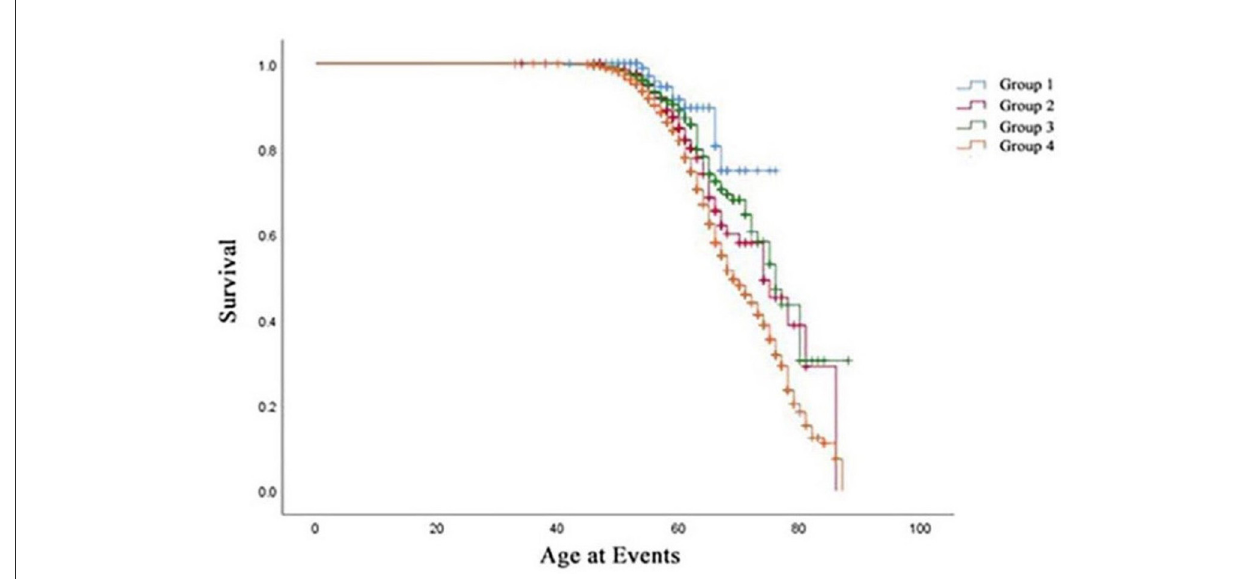
FIGURE5 Kaplan-Meier estimates of survival in the four groups.